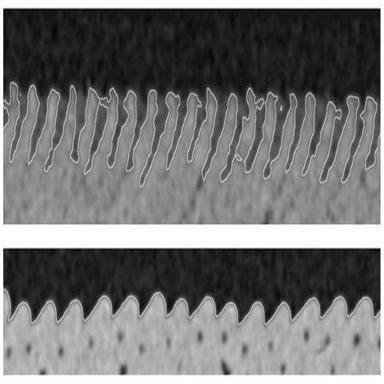
Profile comparison of profiles in XCT. SLS (upper) and FDM (lower).